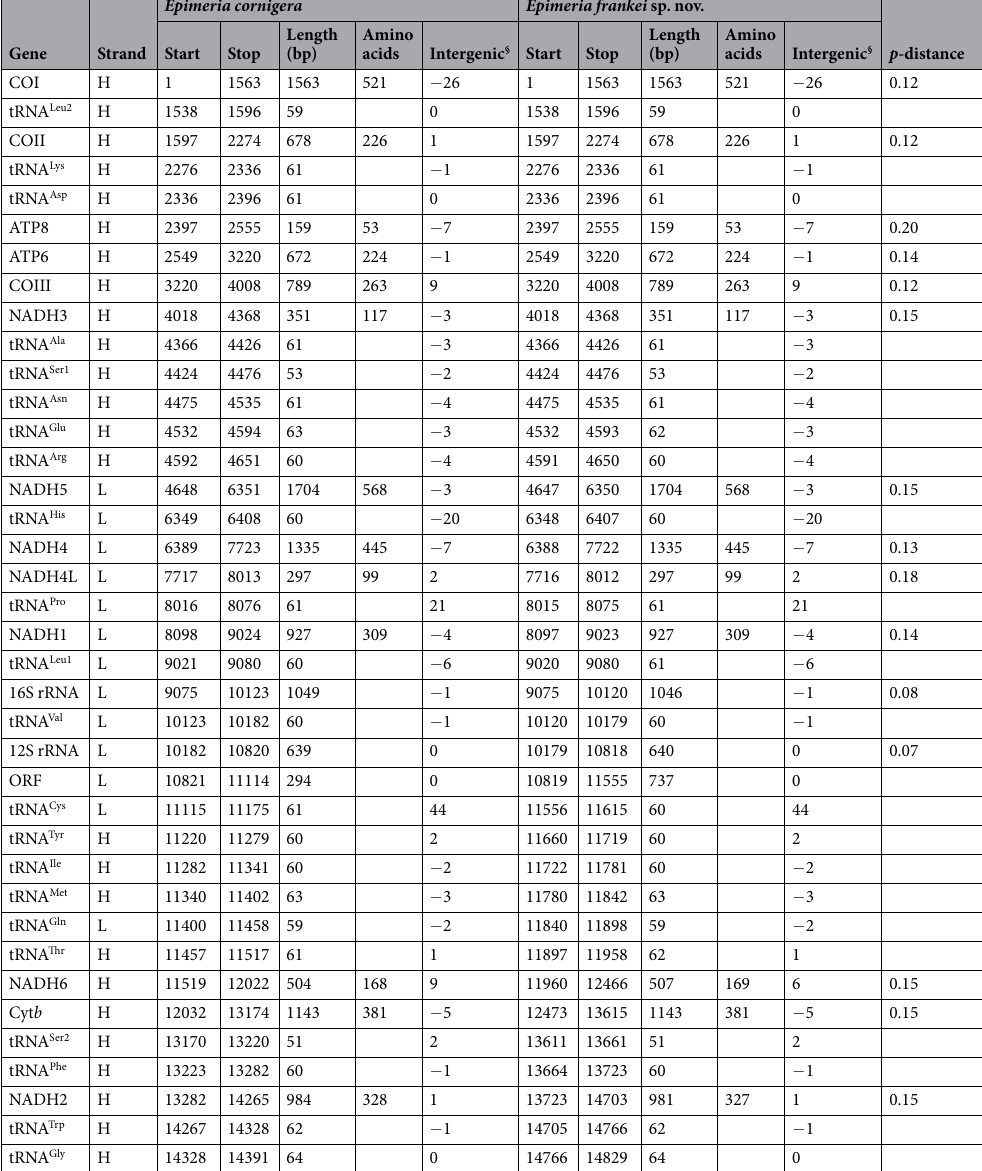
Table 2. Gene structures of the mitochondrial genomes of Epimeria cornigera and Epimeria frankei sp. nov. The letters H (heavy) or L (light) indicate that the gene is encoded either by the H- or L-strand. § Numbers correspond to the nucleotides separating adjacent genes. Negative numbers indicate overlapping